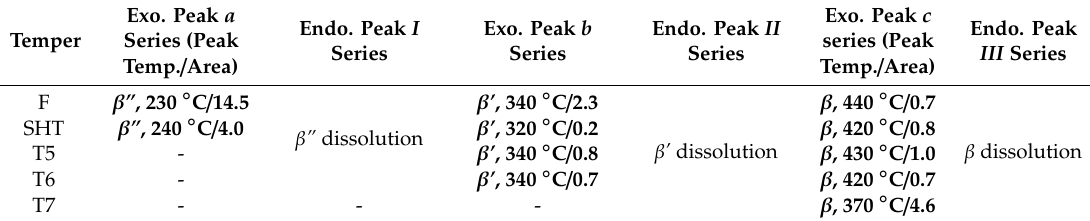
Table 3. Summary of DSC characteristics of the various tempers of the AlSi10Mg0.3Mn alloy.